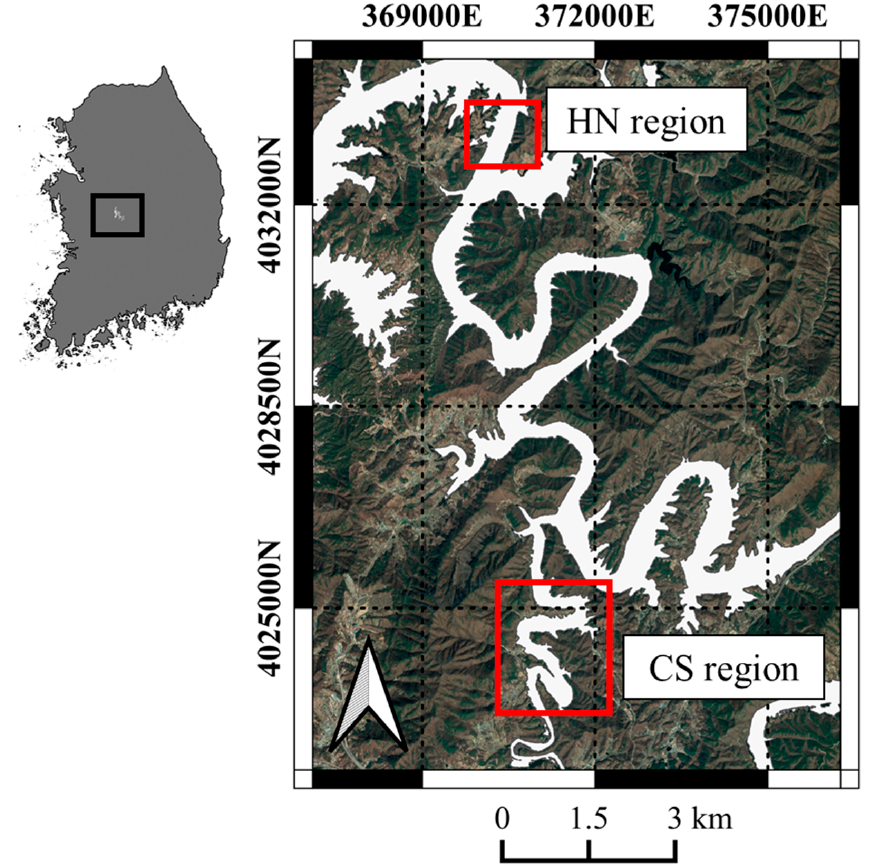
Figure 1. Case study area in the Daecheong dam; the labels “HN region” and “CS region” and the adjacent red boxes indicate the Huinam and Chuso regions, respectively.